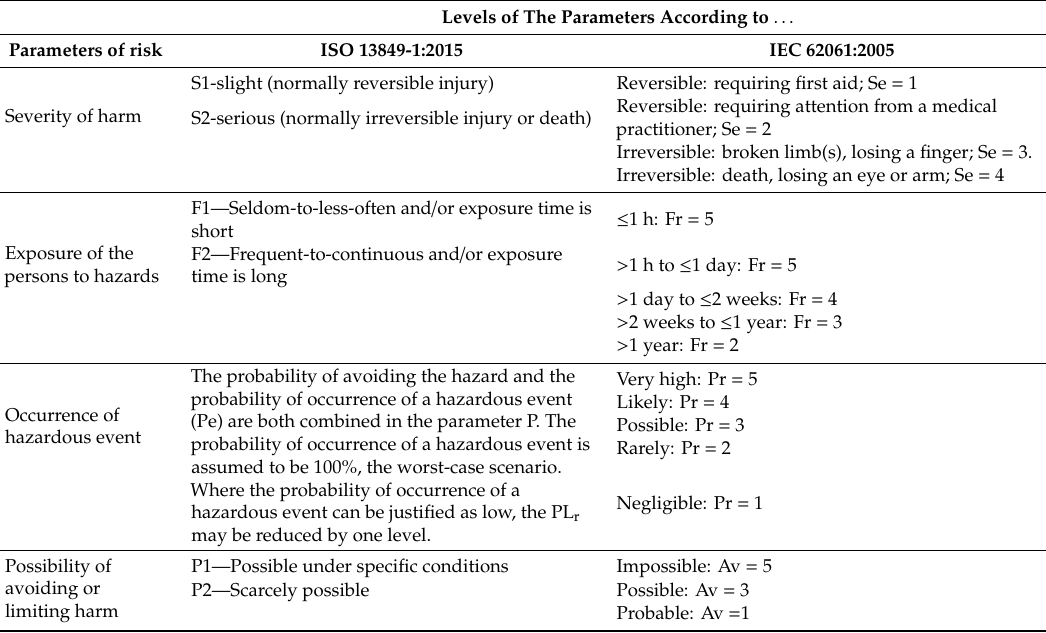
Table 5. Comparison between ISO 13849-1:2015 and IEC 62061:2005 relative to parameters of risk. Levels of The Parameters According to